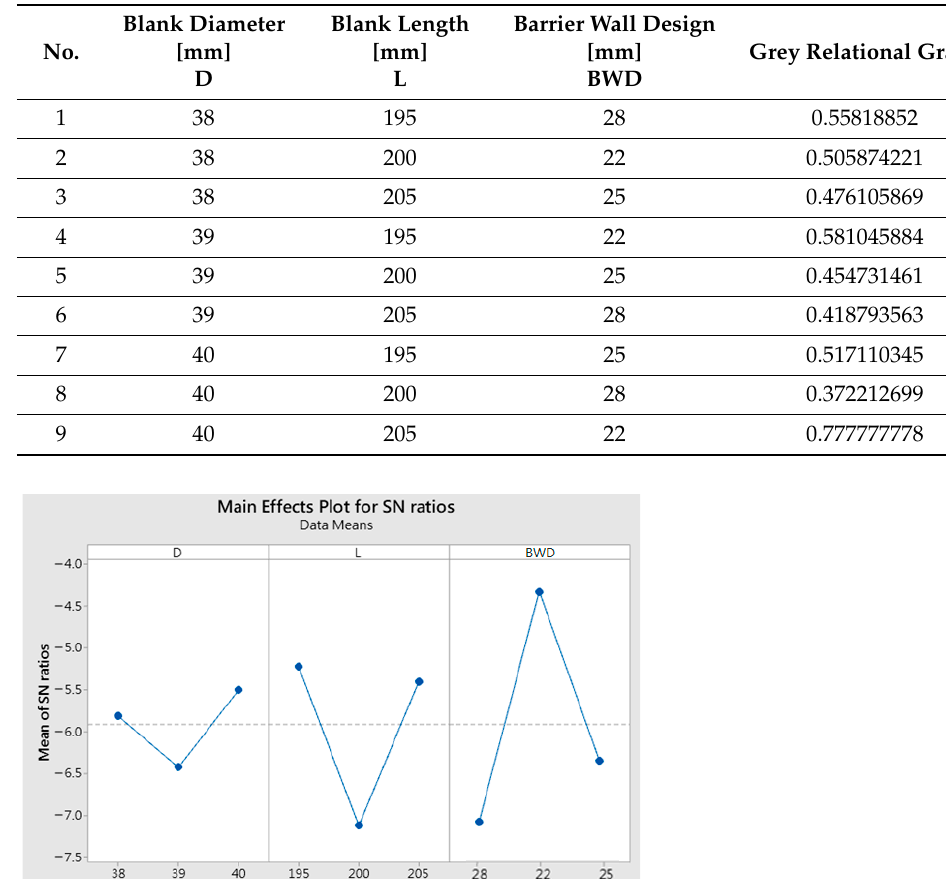
Table 10. Nine (9) experimental groups and GRG (grey relational grade).